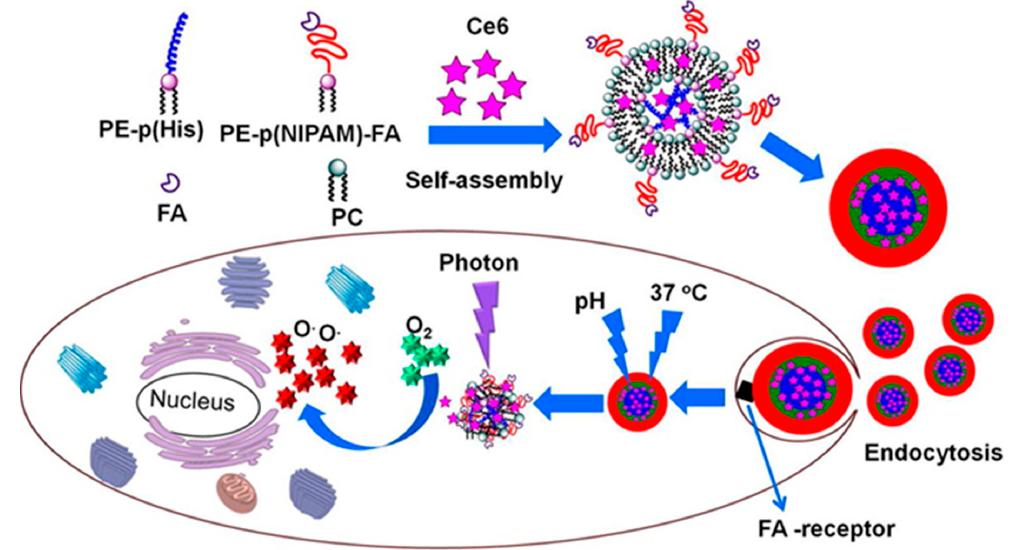
Figure 5. Schematic representation of photodynamic therapy utilizing the self-assemblies of the mixtures of lecithin derived phosphatidylcholine, phosphatidylethanolamine-poly( L -histidine) 40 and folic acid conjugated phosphatidylethanolamine-poly( N -isopropylacrylamide) 40 . Reproduced with permission from [77]. Copyright 2016, American Chemical Society.